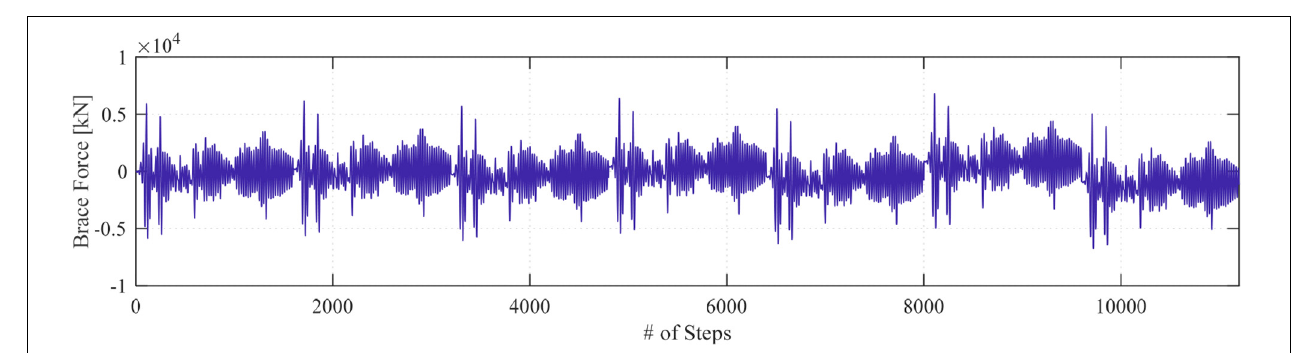
FIGURE 9 | Stacked brace force dataset (Input 2).